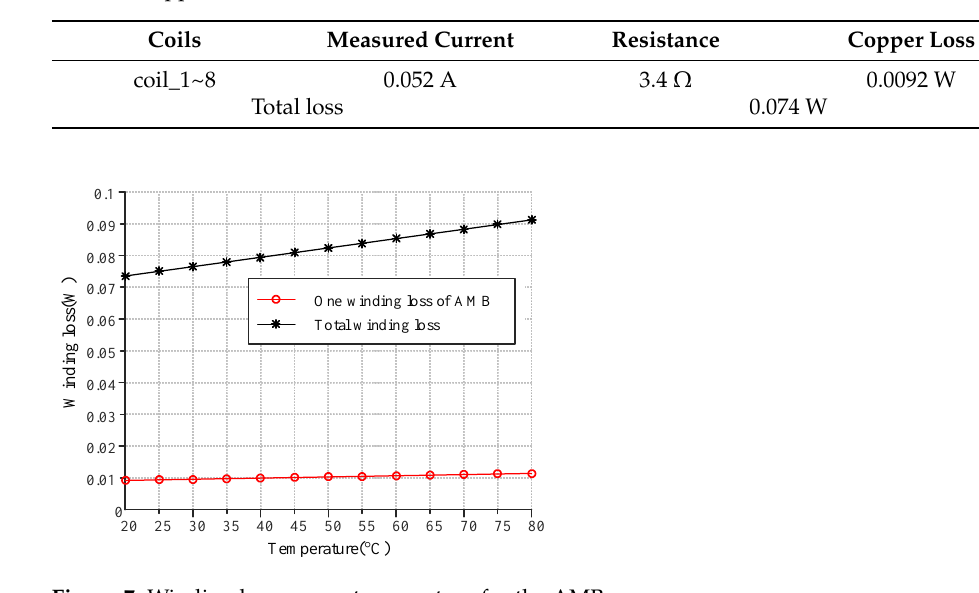
Table 3. Copper loss calculation for the AMB (20 ◦ C).